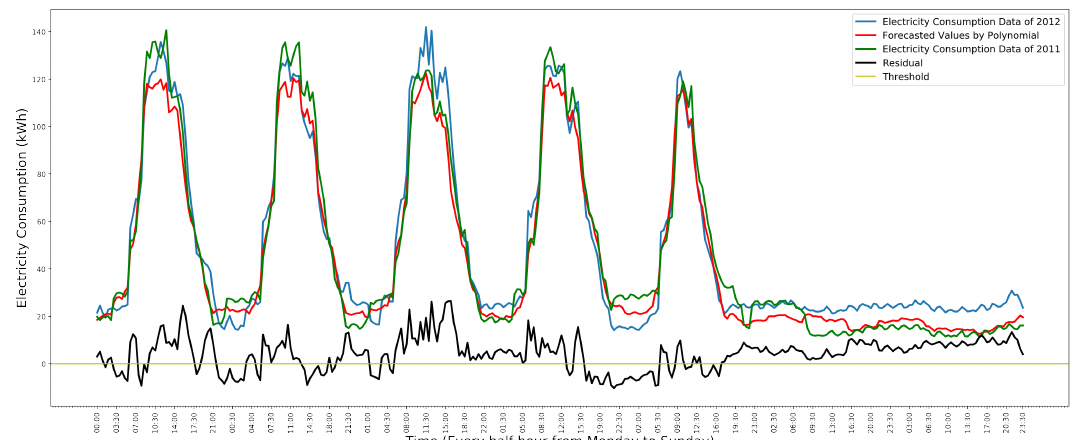
Figure 6. Detecting anomalies in Saturday and Sunday. Adapted from